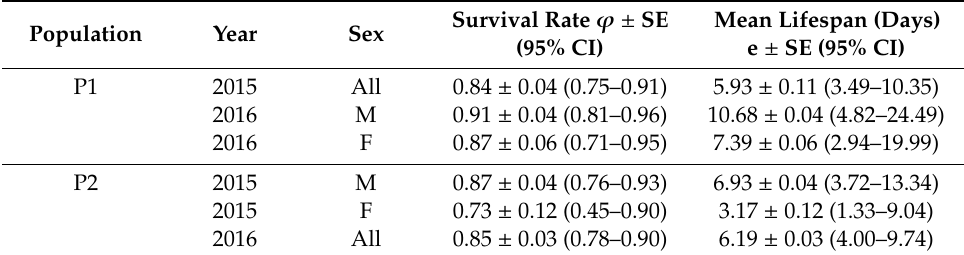
Table 3. Survival rate and mean lifespan of adult butterflies in two populations (P1 and P2) of Scolitantides orion in Poland in two